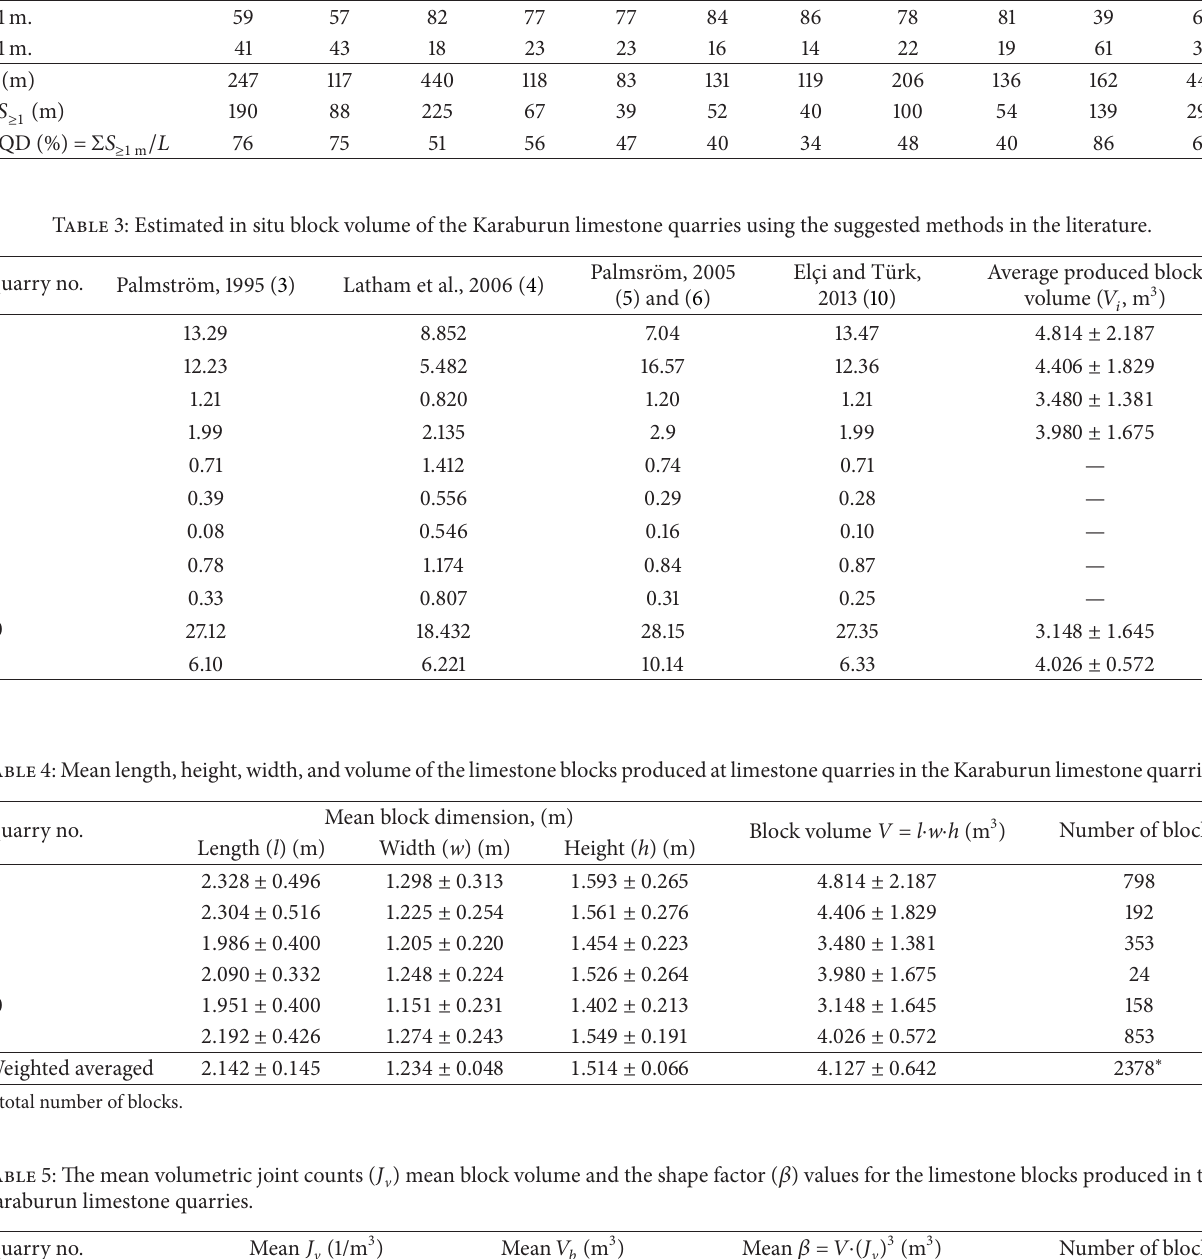
Table 2: Discontinuity spacing frequency of the Karaburun limestone quarries. Quarry no.